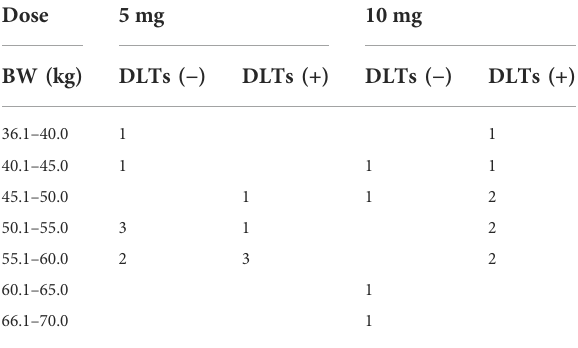
TABLE 4 Patients in opposite DLT groups with 5 and 10 mg doses.